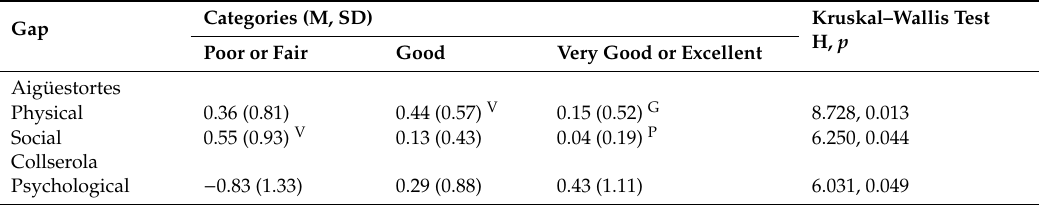
Table A5. Post hoc comparisons for the GAPs between expected benefits and satisfaction according to health